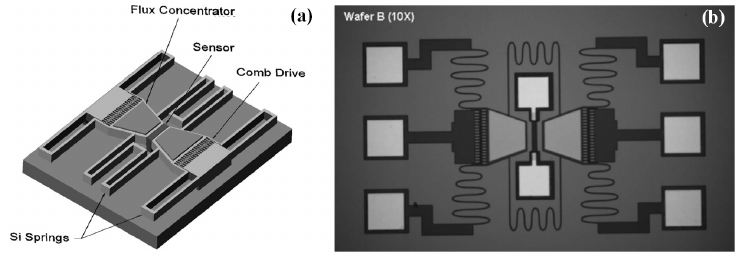
Figure 6. ( a ) Illustration of the concept of the MEMS MFM; ( b ) Scanning electron microscopy (SEM) picture of the MEMS MFM [71].